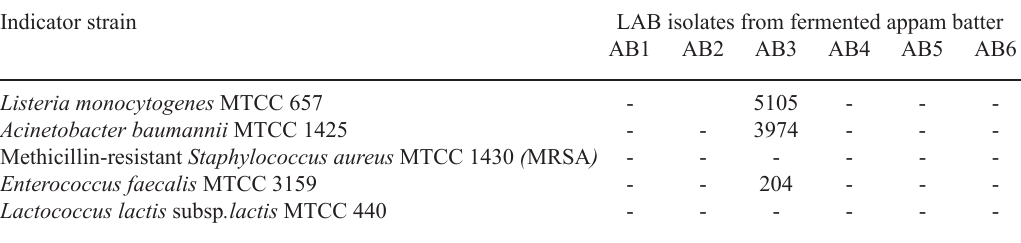
Table 2. Antimicrobial activity (AU/ml)* of CCFs of 6 LAB isolates against the different indicator organisms Indicator